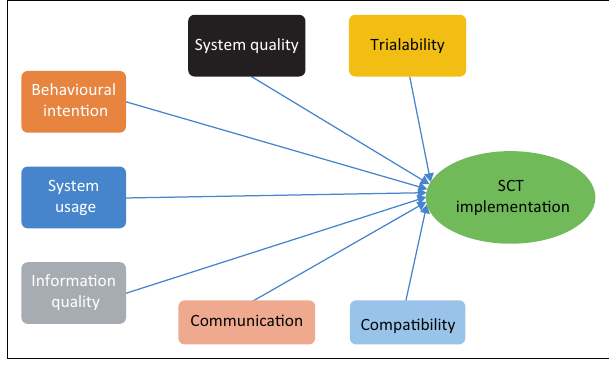
FIGURE 1: Final research